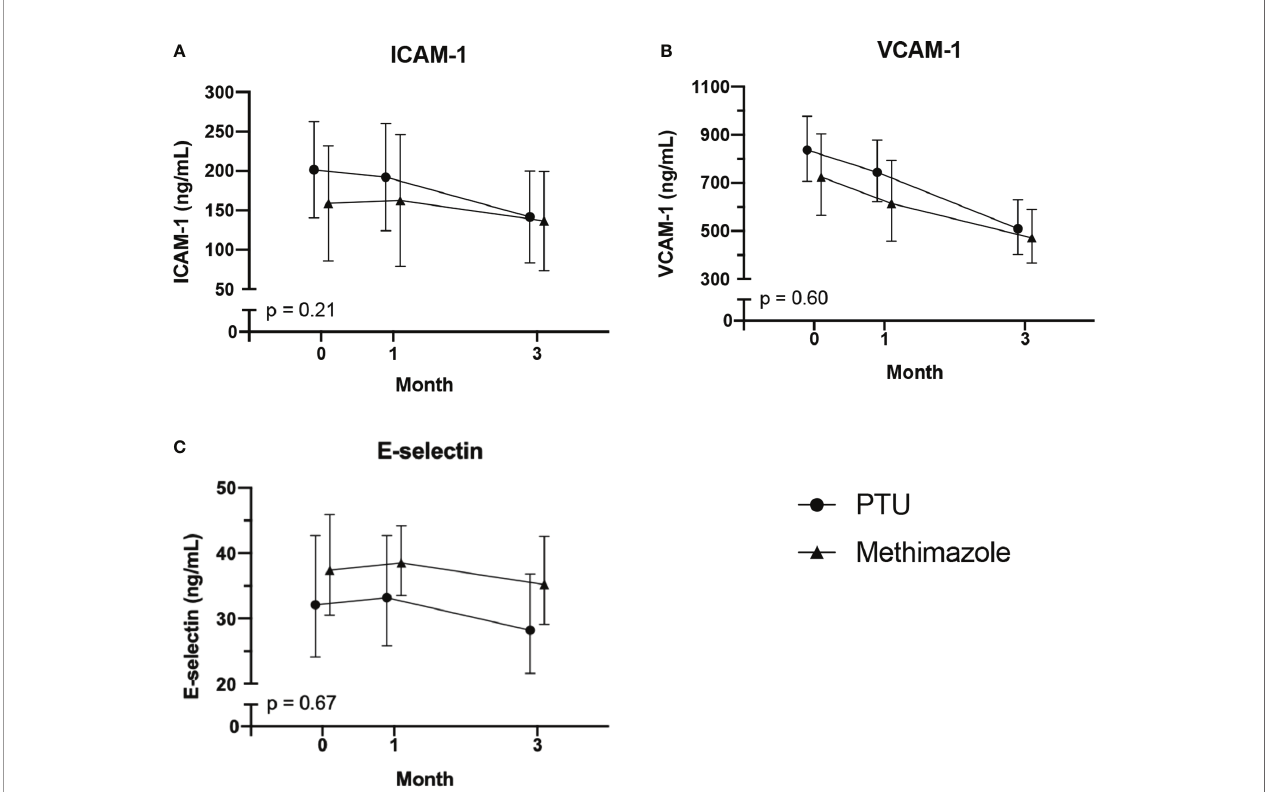
FIGURE 2 | Changes in adhesion molecules: (A) ICAM-1; (B) VCAM-1; (C) E-selectin. After 3 months of antithyroid drug treatment. Intercellular adhesion molecule- 1; VCAM-1 vascular cell adhesion molecule-1. The comparisons were assessed using the general linear model test.